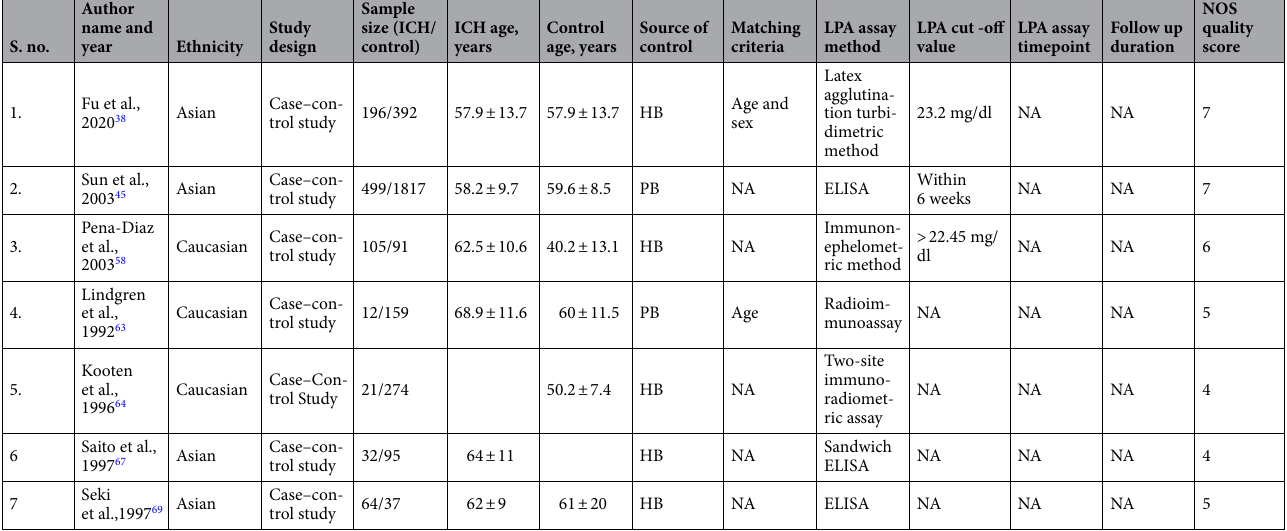
Table 3. Baseline characteristics of studies included in the systematic review and meta-analysis for the relationship between serum Lp(a) levels and risk of intracerebral haemorrhage